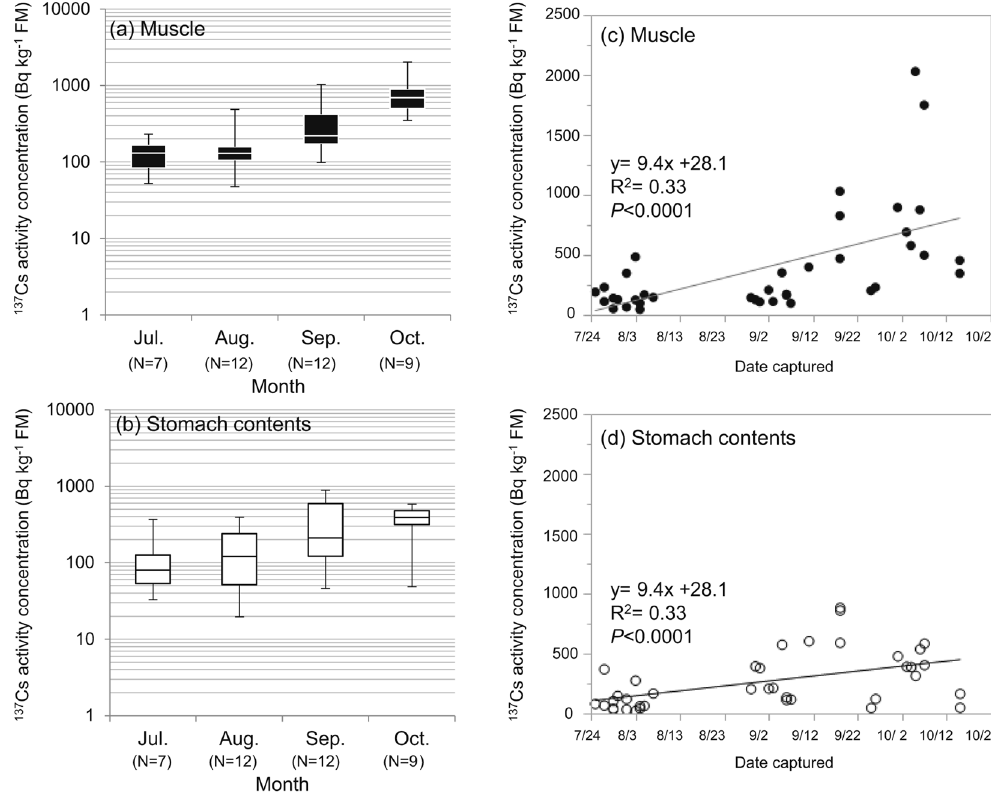
Figure 3. Seasonal variations in the activity concentration of radiocaesium ( 137 Cs) in wild boar muscle tissue and stomach contents. ( a , b ) Monthly changes in the activity concentration of 137 Cs in muscle and stomach contents from July to October in 2015. The upper and lower ends of the box plot indicate the 75th and 25th percentiles, respectively. The horizontal bar in the plot indicates the median value. The whiskers at the upper and lower ends of the box plot indicate the maximum and minimum values, respectively. ( c , d ) Changes in the activity concentration of 137 Cs in muscle and stomach contents on the dates when the animals were captured. The single regression line equation and adjusted R-square (R 2 ) are shown only for the cases where a significant difference was observed between the two variables in regression analysis. FM: Fresh